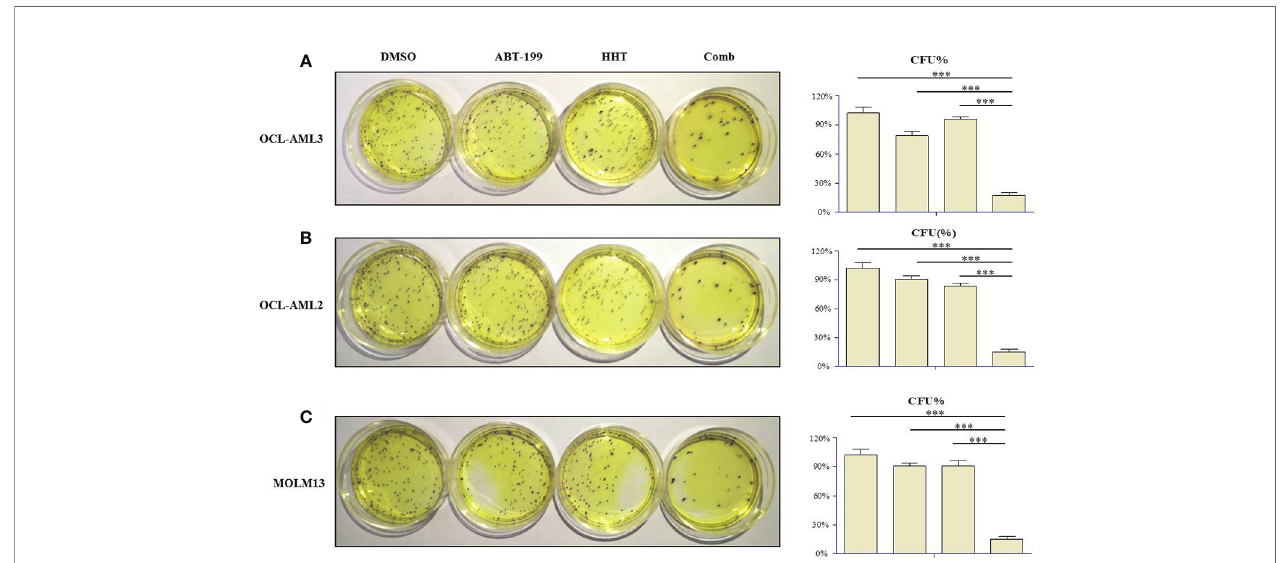
FIGURE 3 | The numbers of colony-forming units (CFU) produced by OCL-AML2, OCL-AML3, and MOLM13 cells exposed to ABT-199 alone (80 nM) or in combination with HHT (16 nM) in a methylcellulose culture system for 24 h (A – C) . The percentage of CFU was determined by counting colonies ( ≥ 50 cells). Data are presented as the mean ± S.D. @ of three independent experiments. (*P < 0.05, **P < 0.01, and ***P < 0.001).